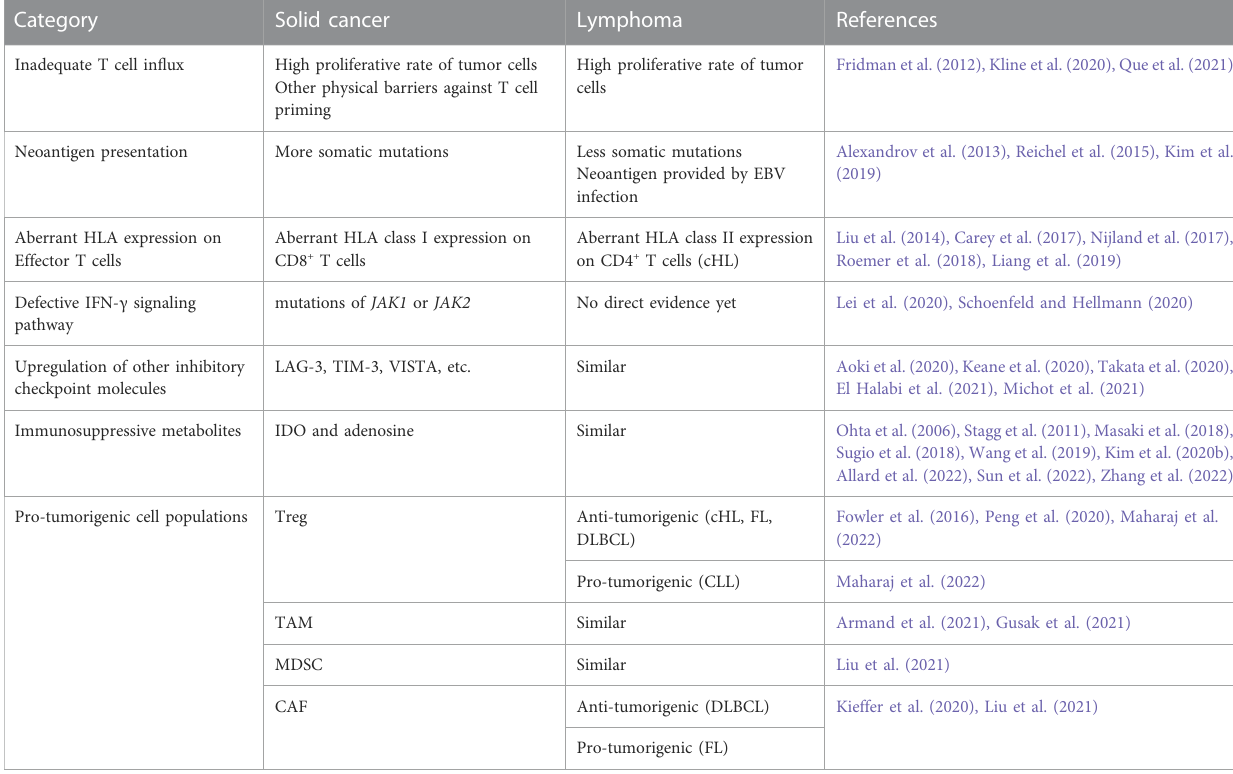
TABLE 2 Comparation of lymphoma and solid cancer in resistance mechanisms to immune checkpoint